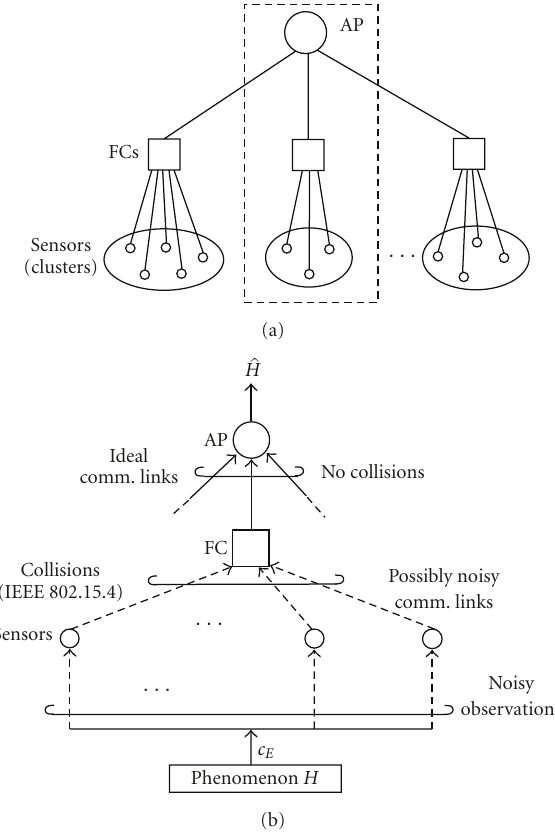
Figure 1: Logical representation of a clustered sensor network (case (a)) and detailed representation of a specific cluster highlighted above (case